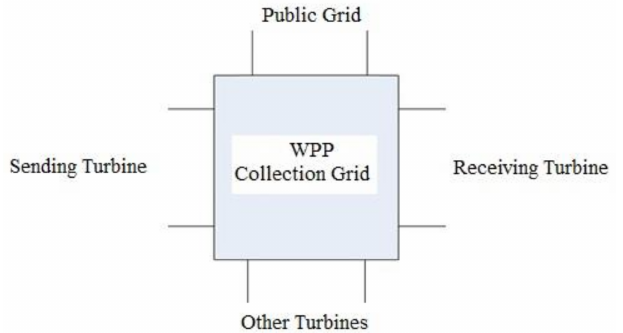
Figure 1. WPP as a multi-port network; each transfer function considers the transfer from one port to another, with a given termination of the other